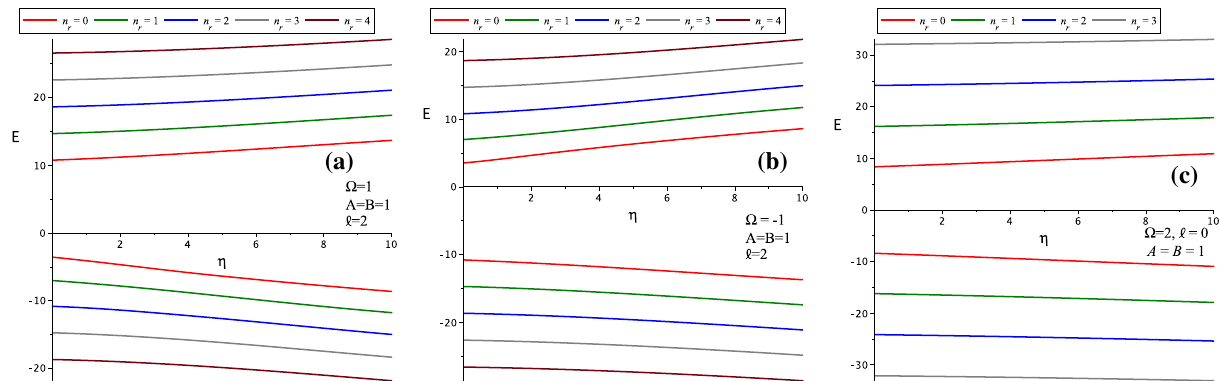
of (23) against the oscillator frequency η at n r = 0 , 1 , 2 , 3 , 4. In r ,(cid:13)